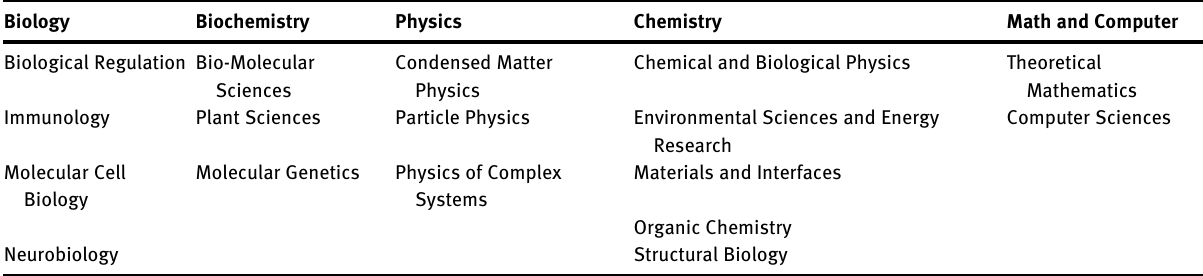
Table  : Faculties and departments of the Weizmann Institute of Science. Biology